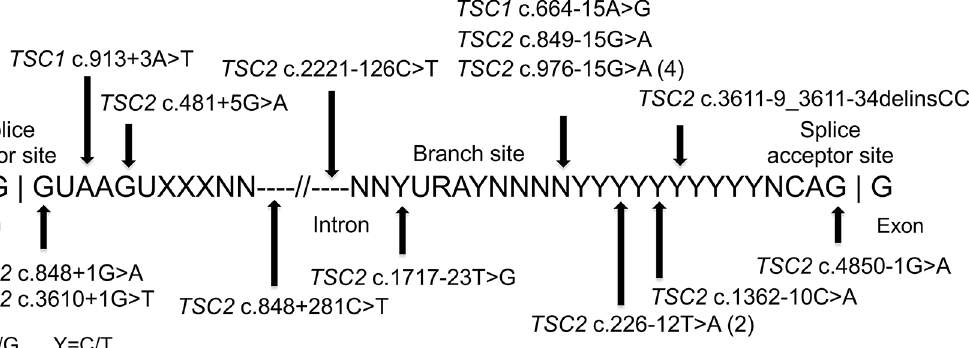
Fig 2. Intronic mutations in 18 TSC NMI subjects. The locations of 18 splice site mutations identified are shown relative to the canonical consensus sequences present at the 3 ’ exon region, the branch site, and the 5 ’ exon region.